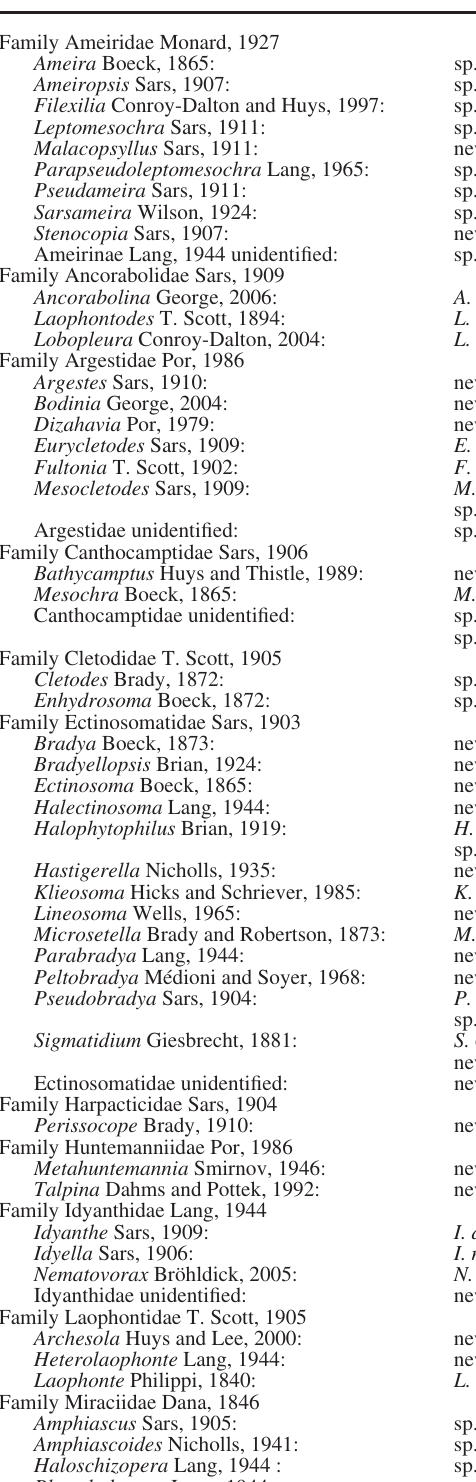
Table 2. – list of identified families, genera and species from the Porcupine seabight. For each species, the number of collected specimens from the coral degradation zone is given (between parentheses). number of collected specimens from coral-free sites 7 and 8 are provided separately ( 7 or 8 : from coral-free site 7 or 8,